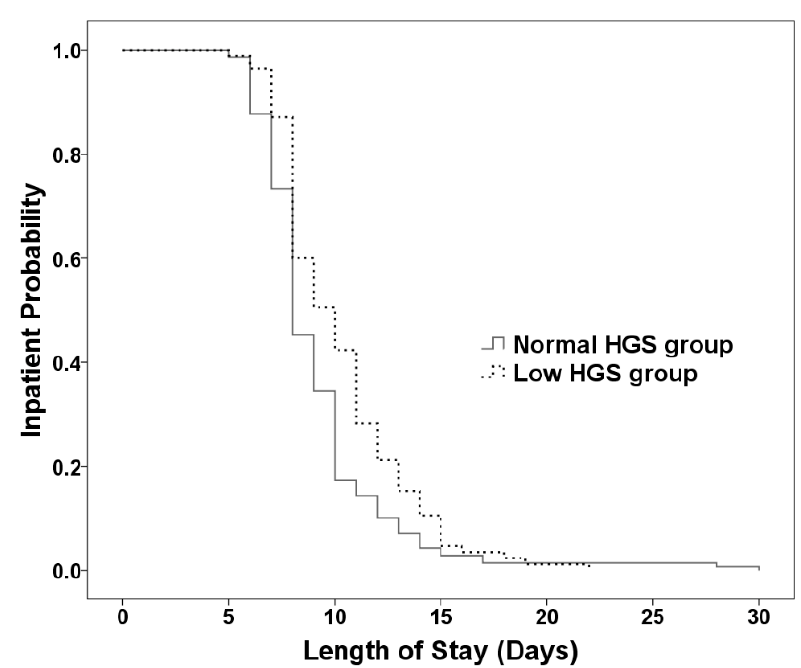
Figure 2. Kaplan − Meier curves for length of hospital stay after lumbar spinal fusion surgery between patients with low and normal handgrip strength (HGS) before surgery (log-rank p = 0.006). Table 4. Association of patient demographics and perioperative clinical variables with a longer length of hospital stay ( ≥ 10 days) after lumbar fusion surgery in univariate and multivariate logistic regression analyses.